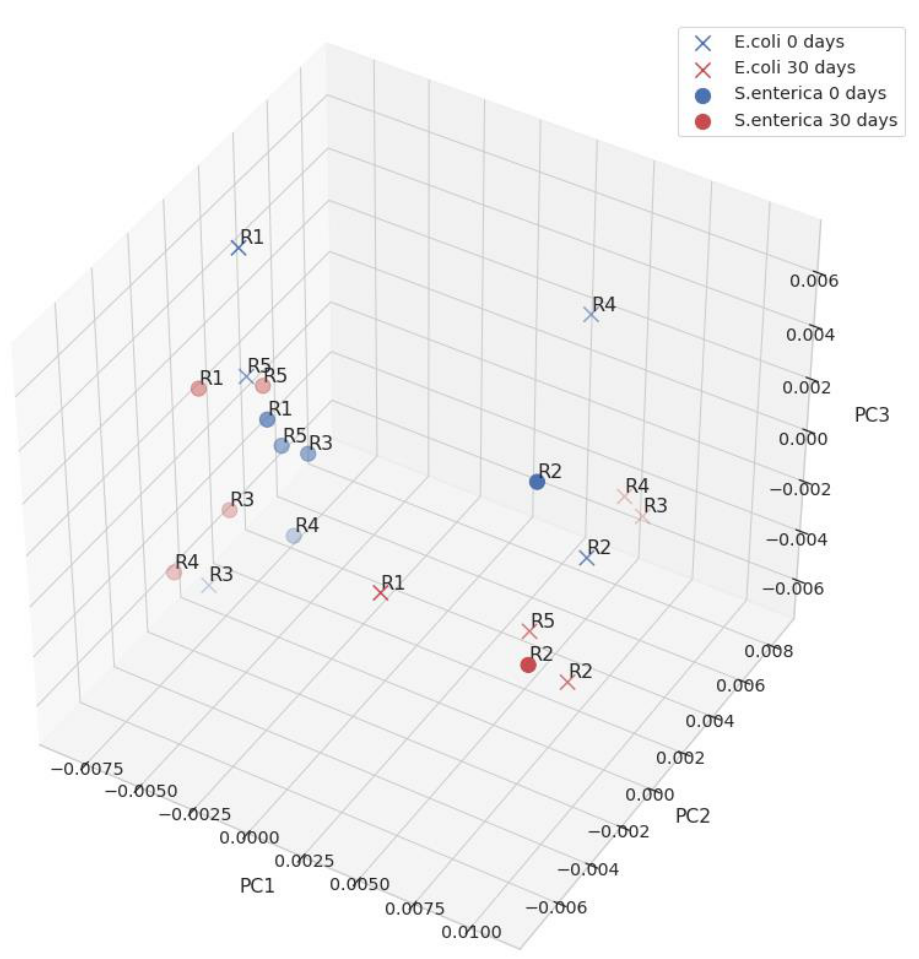
Figure 5. PCA plot for E. coli and S. enterica . Samples on the day of the dissolving and after 30 days of incubation at 37 °C. Points on the left side correspond to aggregates, on the right side to random